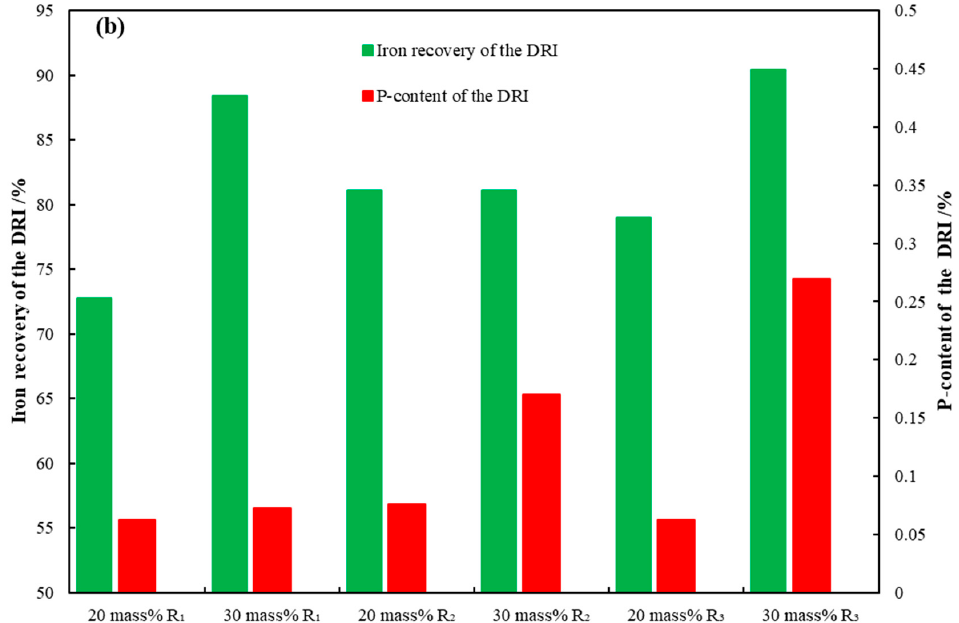
Figure 2. Experimental results of R 1 , R 2 , R 3 and phosphorus removal of briquettes. ( a ) the function of R 1 , R 2 , R 3 on iron grade of DRI; ( b ) the function of R 1 , R 2 , R 3 on iron recovery and P-content of DRI.